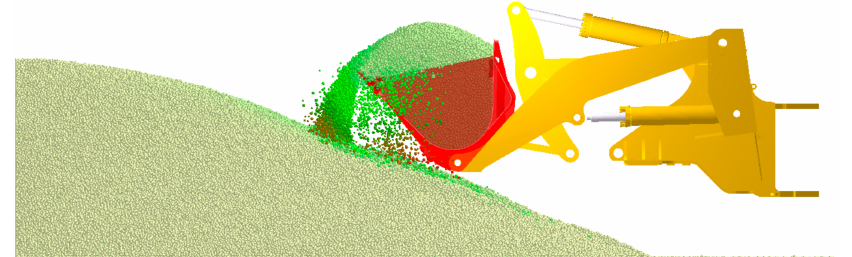
Figure 4. Schematic diagram of co-simulation.